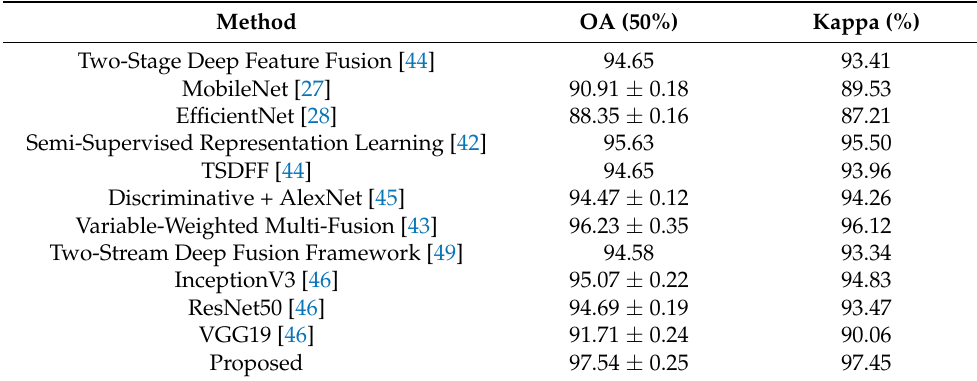
Table 8. Kappa (%) of seven methods and the LCNN-CMGF method at the training ratios of 50% in the AID